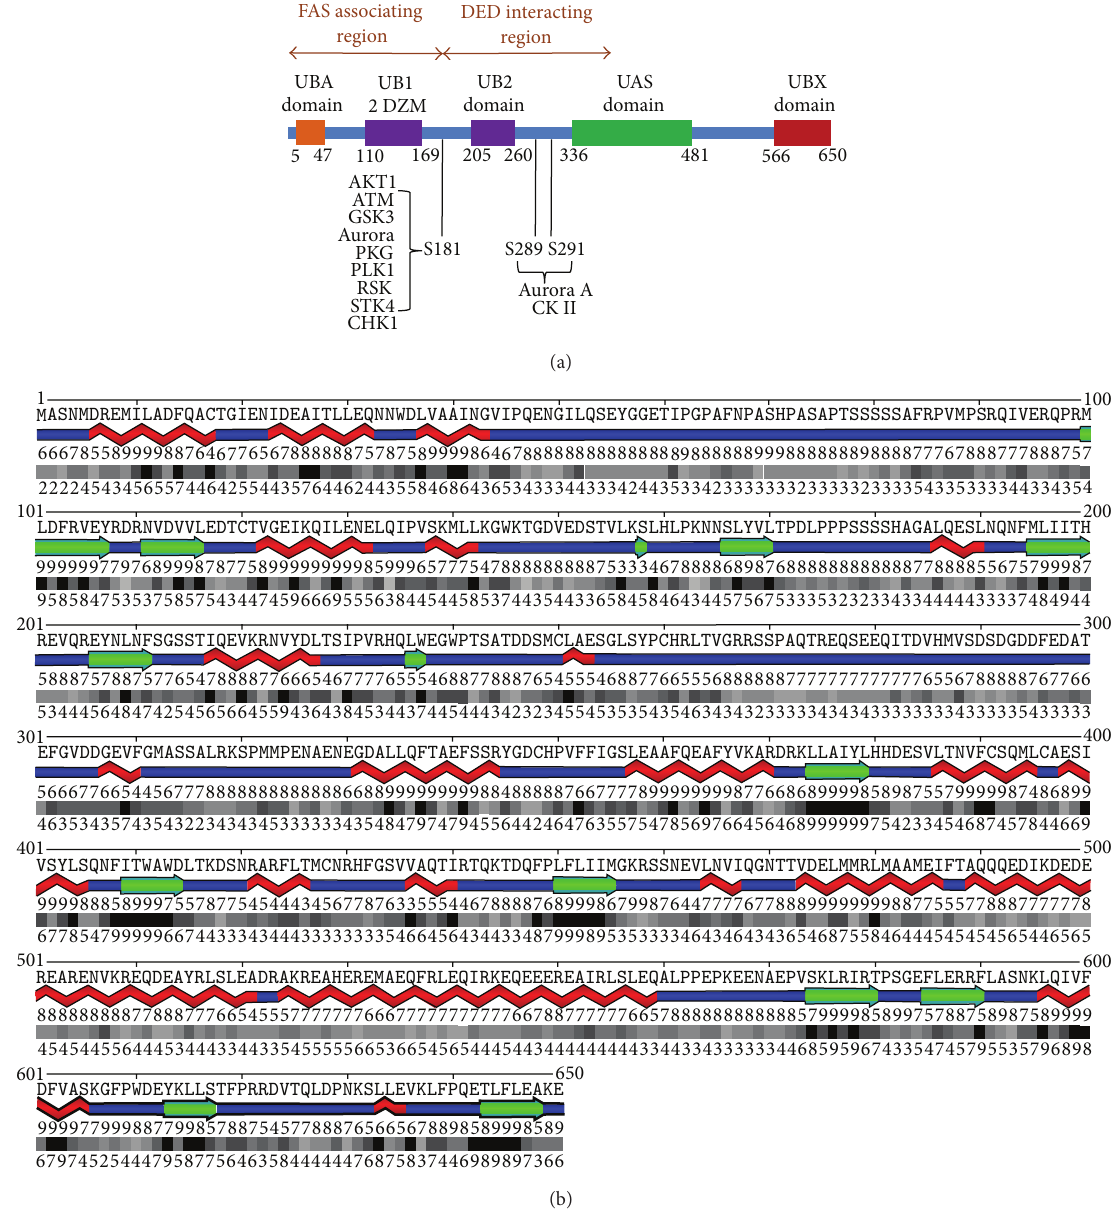
Figure 2: FAF1 structure. (a) A schematic of functional domains in FAF1 with annotations (adapted from [6–8]). There are two ubiquitin- like domains flanking the S181 site. The PDB structure 2DZM identifies the N-terminal one, while the C-terminal prediction is by sequence similarity. Whereas the mutation S181G is not expected to disrupt the protein structure per se, this amino acid has a high score as a possible phosphorylationsiteforanumberofkinasesinvolvedinDNAdamagerepair.(b)SecondarystructurepredictionofFAF1.Theresiduesaround S181 appear